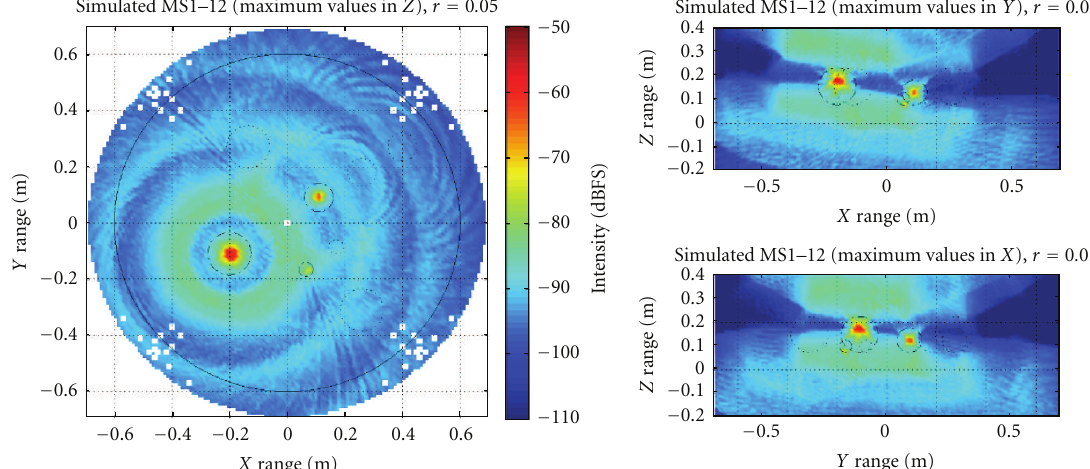
Figure 22: Maximum intensity in X , Y , Z dimensions for the 3 spherical targets described in Table 2, when imaged by the MS spherical-target SWISAR algorithm.